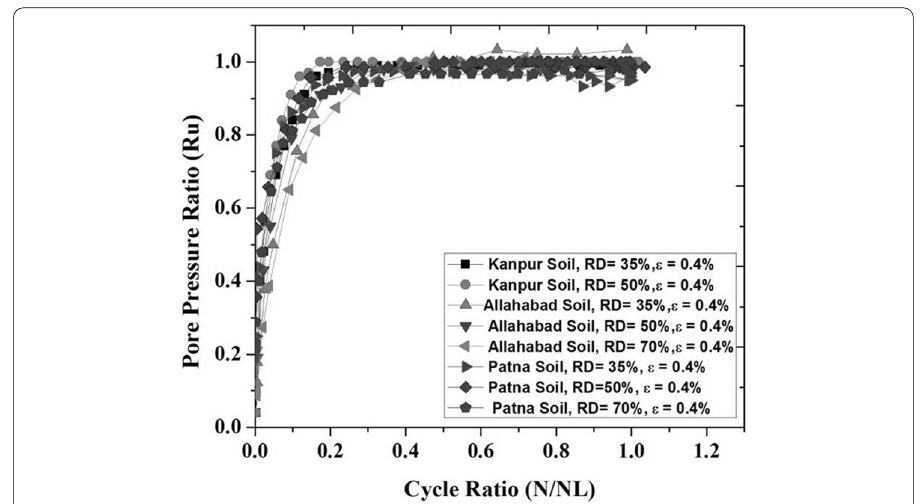
Fig. 9 Relationship between normalized pore pressure ratio for Kanpur soil, Allahabad soil and Patna soil (RD 35%, 50 % and 70%, strain amplitude =